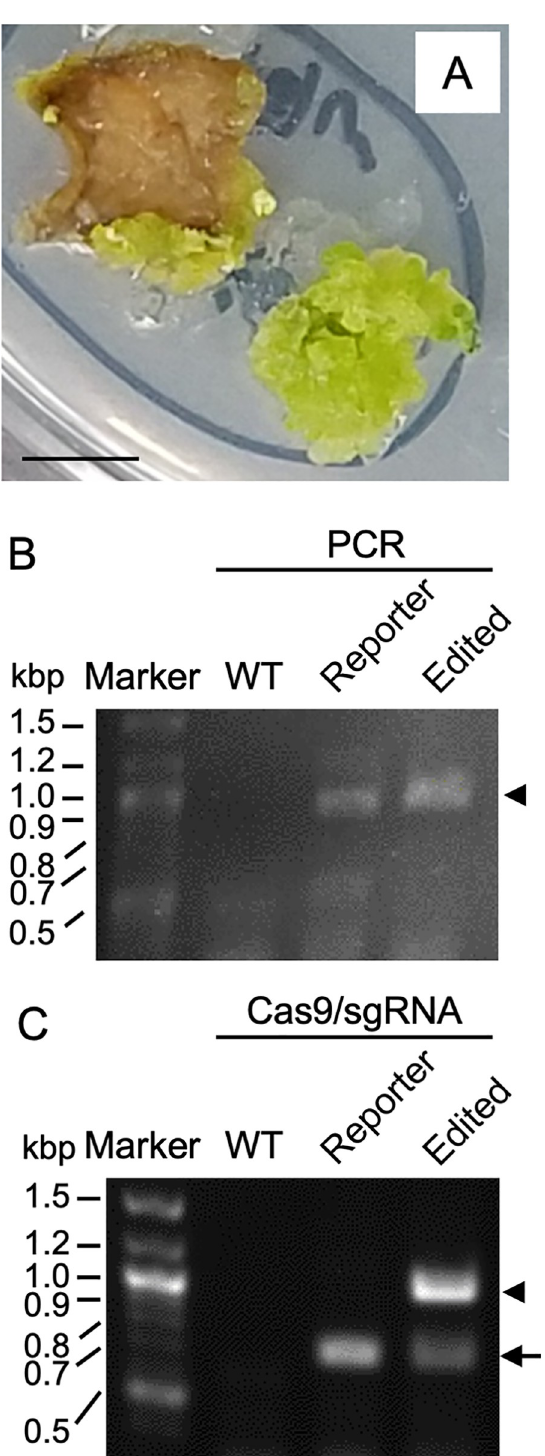
Fig 6. Detection of genome-edited tobacco cells. (A) A green callus appeared in the regeneration medium in the presence of hygromycin. Bar; 1 cm. (B) Parts of sGFP and HPT containing the waxy sequence were amplified by PCR from genomic DNA extracted from the callus shown in (A) (Edited), untreated tobacco leaf with (Reporter) and without (WT) the sGFP-wTALEN-HPT reporter gene. The amplified fragment was shown by agarose gel electrophoresis. Note that no detectable band was obtained in WT, indicating that the fragment was amplified from the